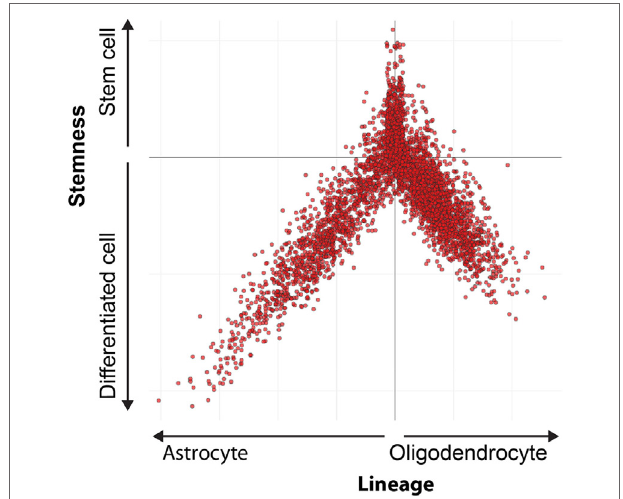
FiGUre 2 | Differentiation hierarchy in oligodendrogliomas. Differentiation hierarchy based on differentiation scores (X) and stem cell scores (Y). Three distinct expression programs: oligodendrocyte (positive X, negative Y), astrocyte (negative X, negative Y), and stem cells (positive Y). Each dot represents a single cell. Reprinted by permission from Tirosh et al.